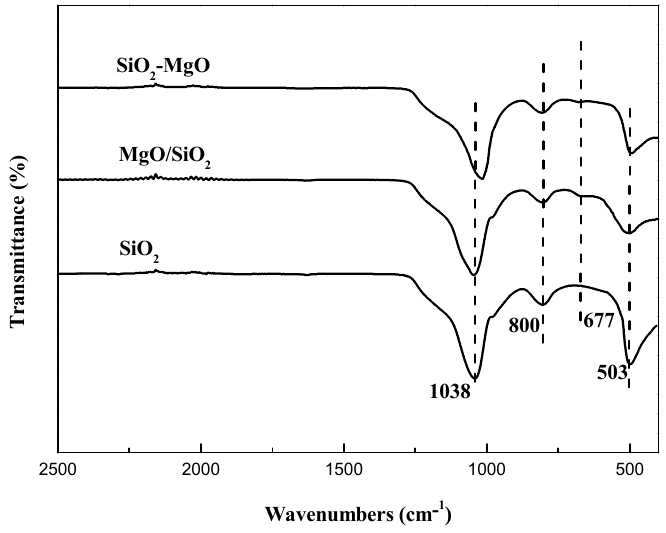
Figure 3. FT-IR spectra of the supports.